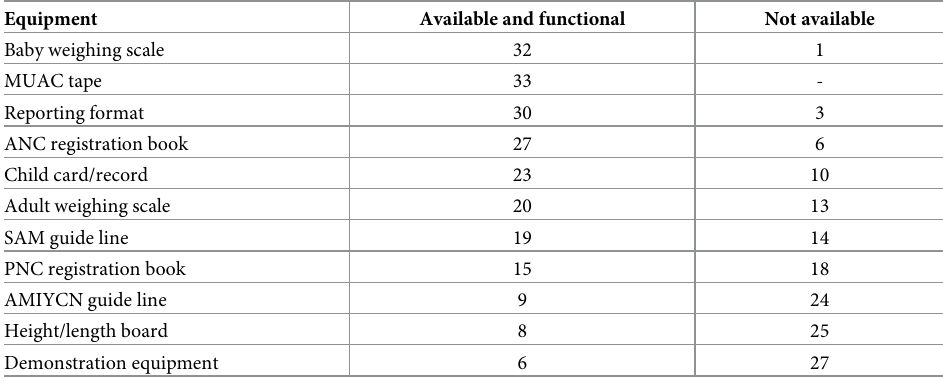
Table 2. Availability of equipment, guidelines and record keeping registers at health posts (n = 33). Equipment Available and functional